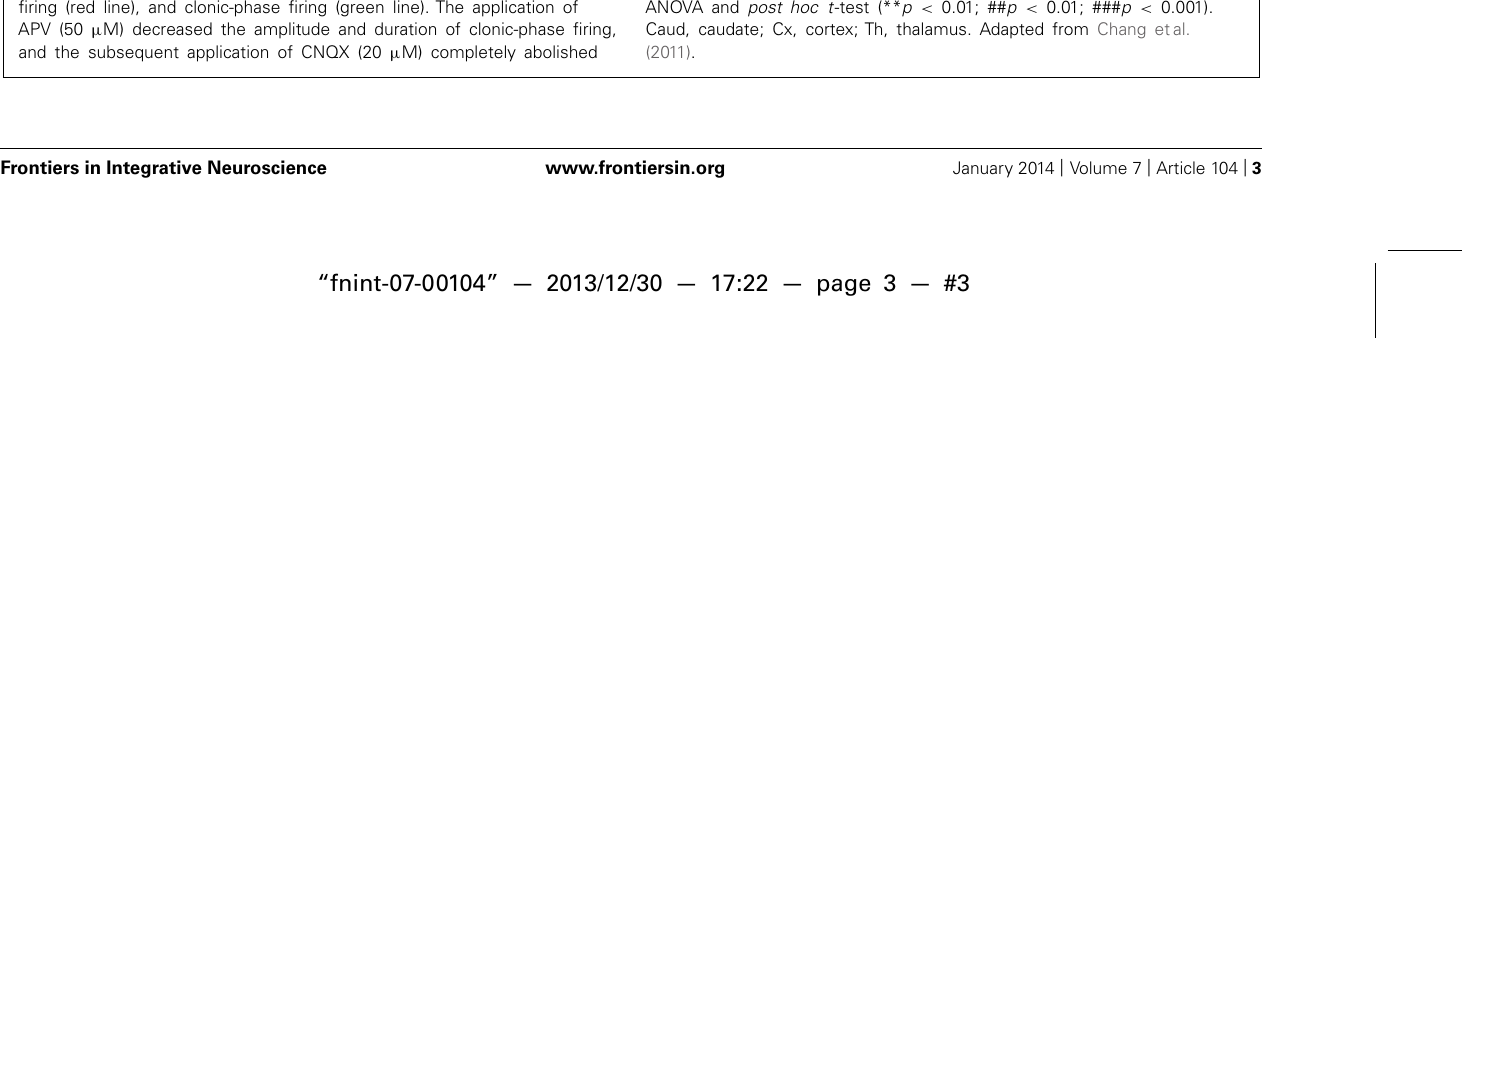
tonic- and clonic-phase firing. The application of CNQX also decreased the amplitude of ictal discharges. (C) The statistical results showed that both the amplitude and duration of epilepsy were significantly decreased after application of APV and CNQX. Comparison were performed